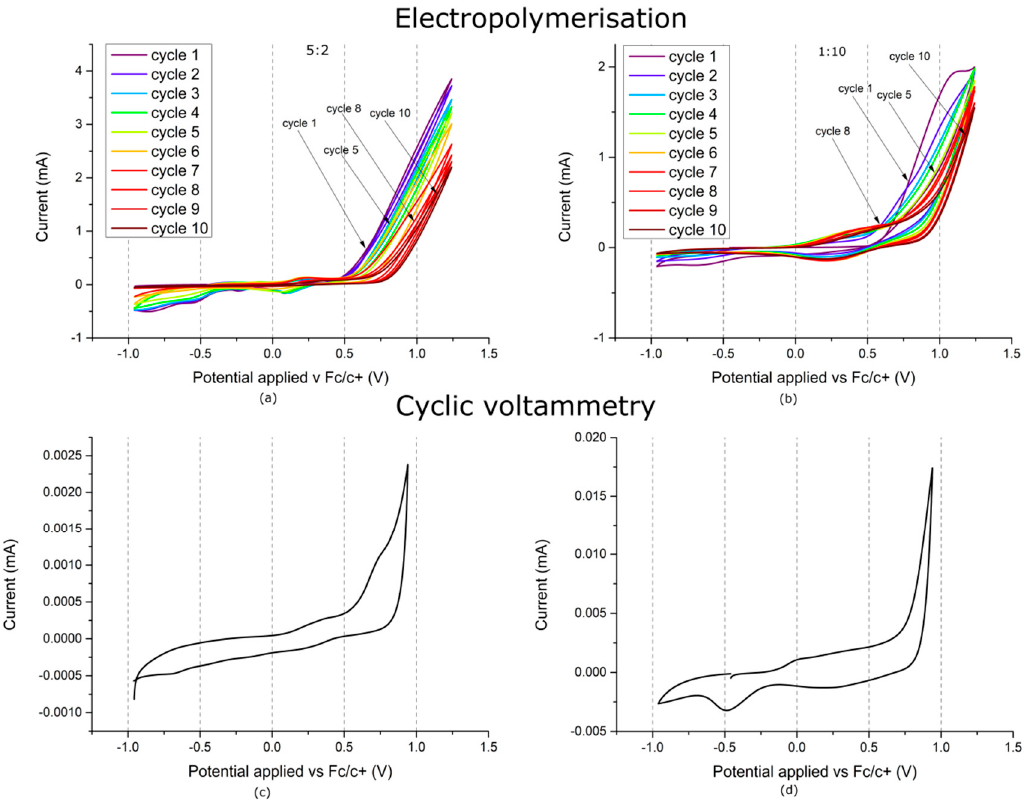
Figure 2. Electrochemical polymerisation of In-HT 5:2 ( a ), In-HT 1:10 ( b ), CVs of deposited In-HT 5:2 EP ( c ), In-HT 1:10 EP ( d ) layers.